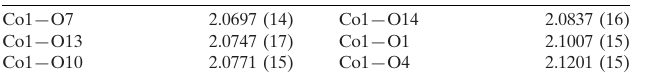
Selected bond lengths (A˚ ).